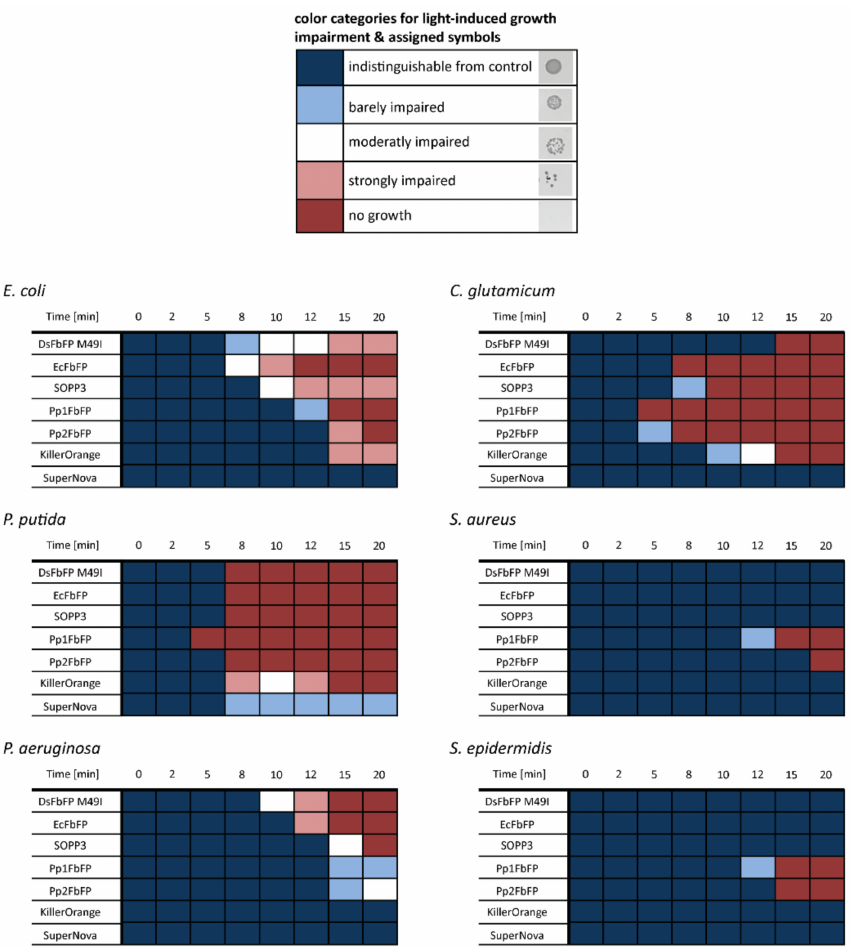
Figure 4. Extracellular antimicrobial activity of seven genetically encoded PSs against di ff erent bacterial strains. The growth responses of E. coli , P. putida , P. aeruginosa , C. glutamicum , S. aureus, and S. epidermidis were analyzed after addition of PSs by a plate spot assay. The detected colony formations were classified into five categories according to their cell survival: no growth impairment (dark blue), barely impaired growth (light blue), moderately impaired growth (white), strongly impaired growth (light red), and completely killed cells (dark red). For a better understanding of the data, the observed colony appearances, which correspond to the respective color categories, are shown in the upper